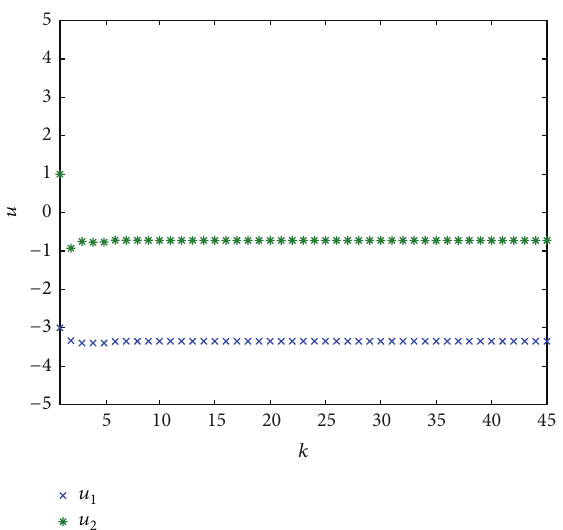
Figure 1: The trajectory of solutions of system (1) in Example 1.